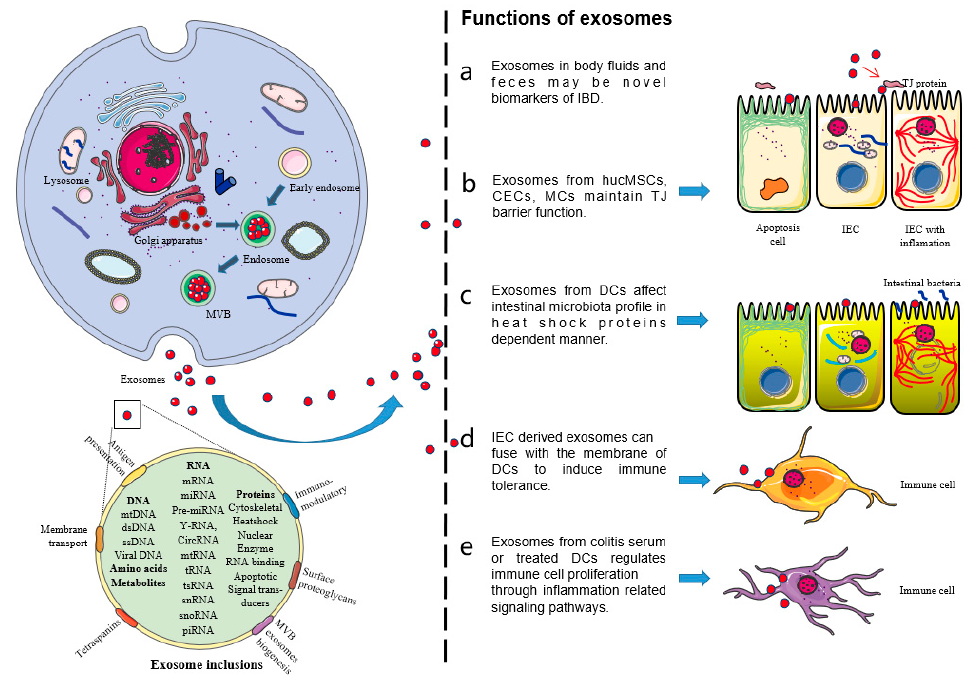
Figure 1. The maturation and secretion mechanisms of exosomes and the functions of exosomes in diseases. After most endosomes mature to multivesicular bodies (MVB) or late endosomes, their contents, RNAs, proteins, lipids, etc., are packaged as intraluminal vesicles (ILVs) in MVB. With the fusion of MVB and cell membrane, ILVs are released as exosomes and enter target cells by endocytosis, which affects the physiological and pathological mechanisms of target cells, such as proliferation, apoptosis, activation, and inhibition. Exosomes affect the functions of the target cells through their inclusions, such as non-coding RNA, proteins, and lipids. ( a ) Exosomes in body fluids and feces may be novel biomarkers of IBD. ( b ) Exosomes from human umbilical cord mesenchymal stem cells (hucMSCs), colonic epithelial cells (CECs), and mast cells (MCs) maintain the tight junction (TJ) barrier function. ( c ) Exosomes from dendritic cells (DCs) affect the intestinal microbiota profile in heat shock proteins-dependent manner. ( d ) Intestinal epithelial cell (IEC)-derived exosomes can fuse with the DCs membrane to induce immune tolerance. ( e ) Exosomes from colitis serum or treated DCs regulate the immune cell proliferation through inflammation-related signaling pathways.